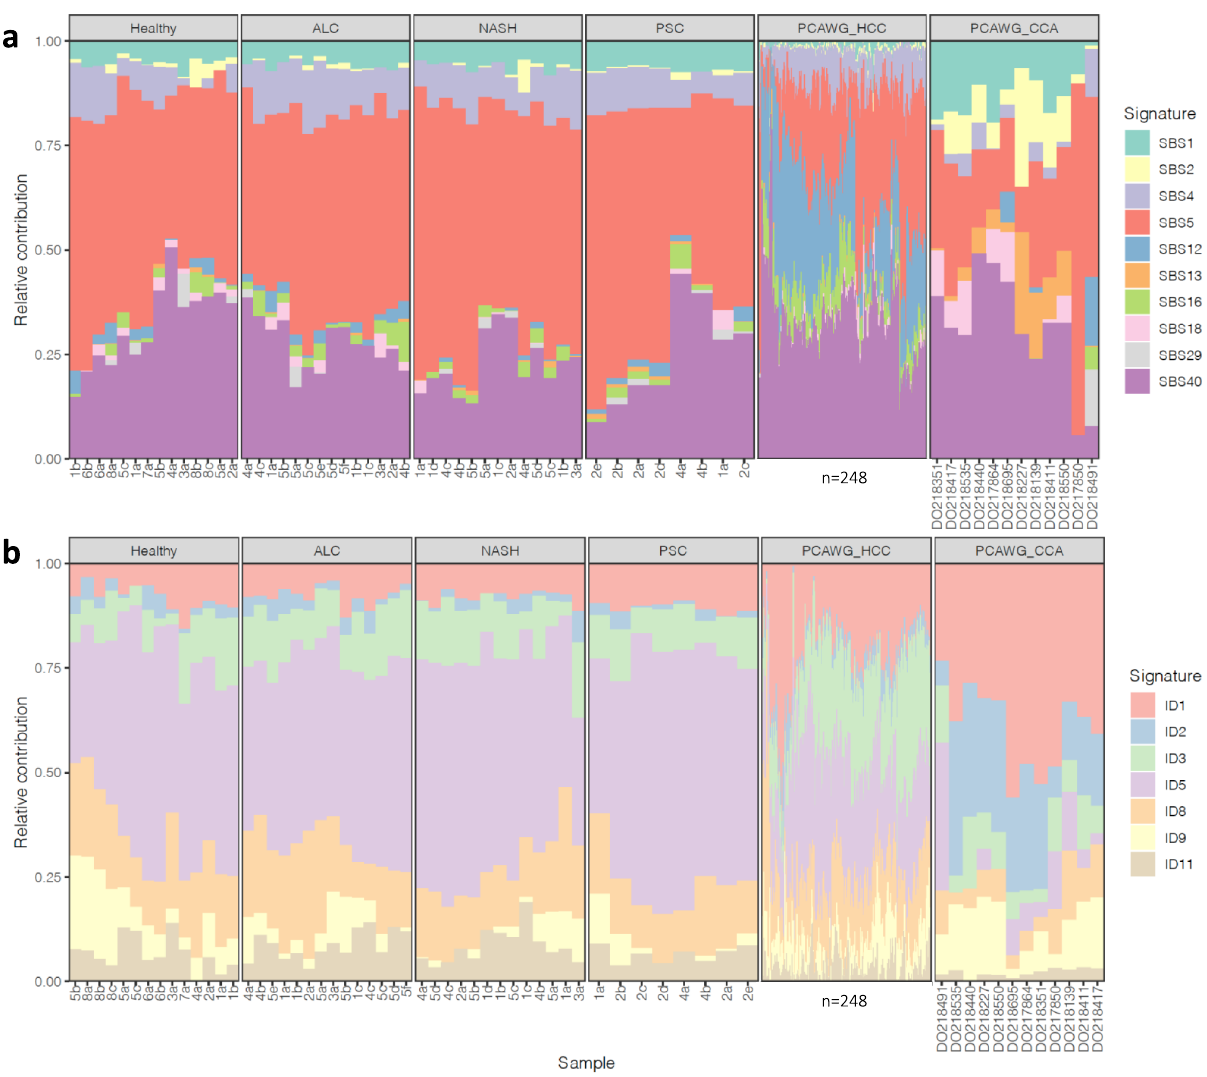
Fig. 3 Relative contributions of mutational signatures in organoids derived from biopsies of healthy, diseased and cancerous livers. a Single base substitution (SBS) signatures. b Indel (ID) signatures. ALC alcoholic cirrhosis, NASH non-alcoholic steatohepatitis, PSC primary sclerosing cholangitis, HCC hepatocellular carcinoma, CCA cholangiocarcinoma. Pro fi les for HCC (PCAWG_HCC; n = 248) and CCA (PCAWG_CCA; n = 12) samples from the Pan- Cancer Analysis of Whole Genomes (PCAWG) consortium are also shown. Hierarchical clustering of samples was performed separately for SBS and ID signatures. Sample names for PCAWG_HCC samples are hidden due to the large number